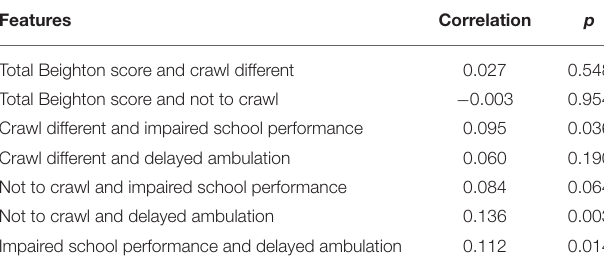
TABLE 7 | Correlation analysis between motor performance variables, Beighton score, impaired school performance, and motor performance